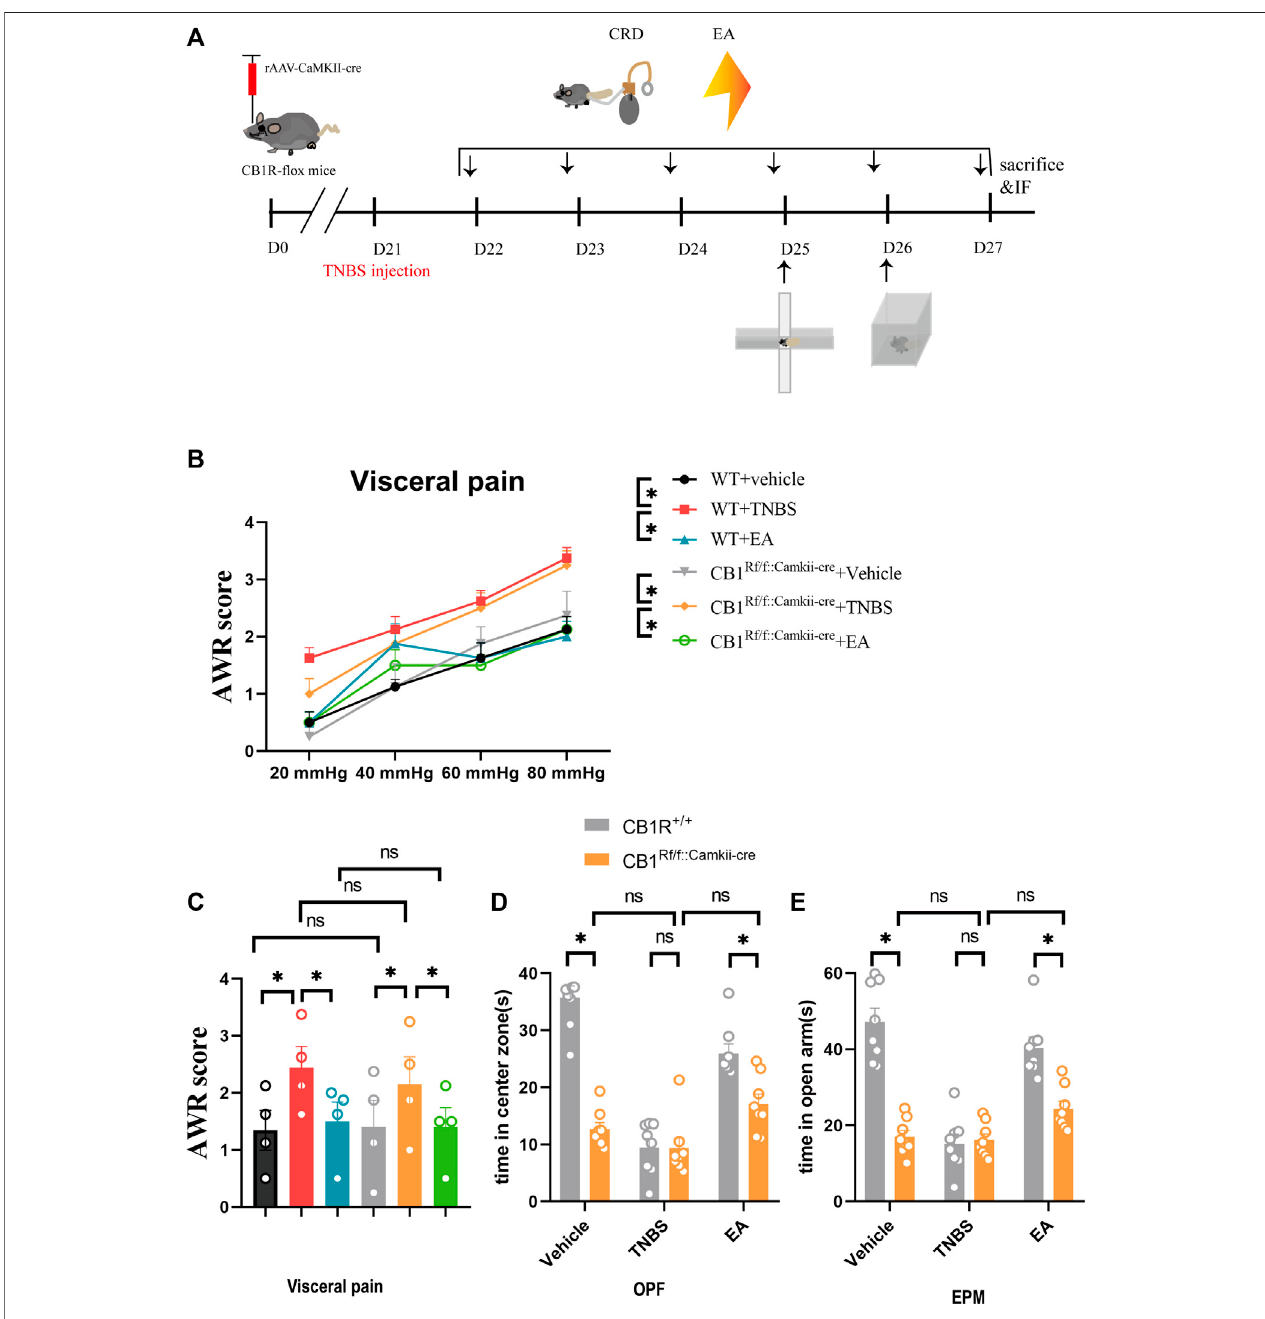
FIGURE 6 | Speci fi c knock out of the CB1R in glutamatergic neurons in the vHPC reversed the anxiolytic but not analgesic effect of EA on IBD mice. (A) Experimental fl owchart. (B,C) Visceral hyperalgesia was evaluated by CRD. (D) Anxiety-related behaviors were recorded as time in center zone in the OPF. (E) Anxiety- relatedbehaviorswererecordedastimeinopenarmsintheEPM.Thedataareexpressedasmean±SEM(n=8mice).*represents p < 0.05betweenmarkedgroups,ns represents p > 0.05 between marked groups.